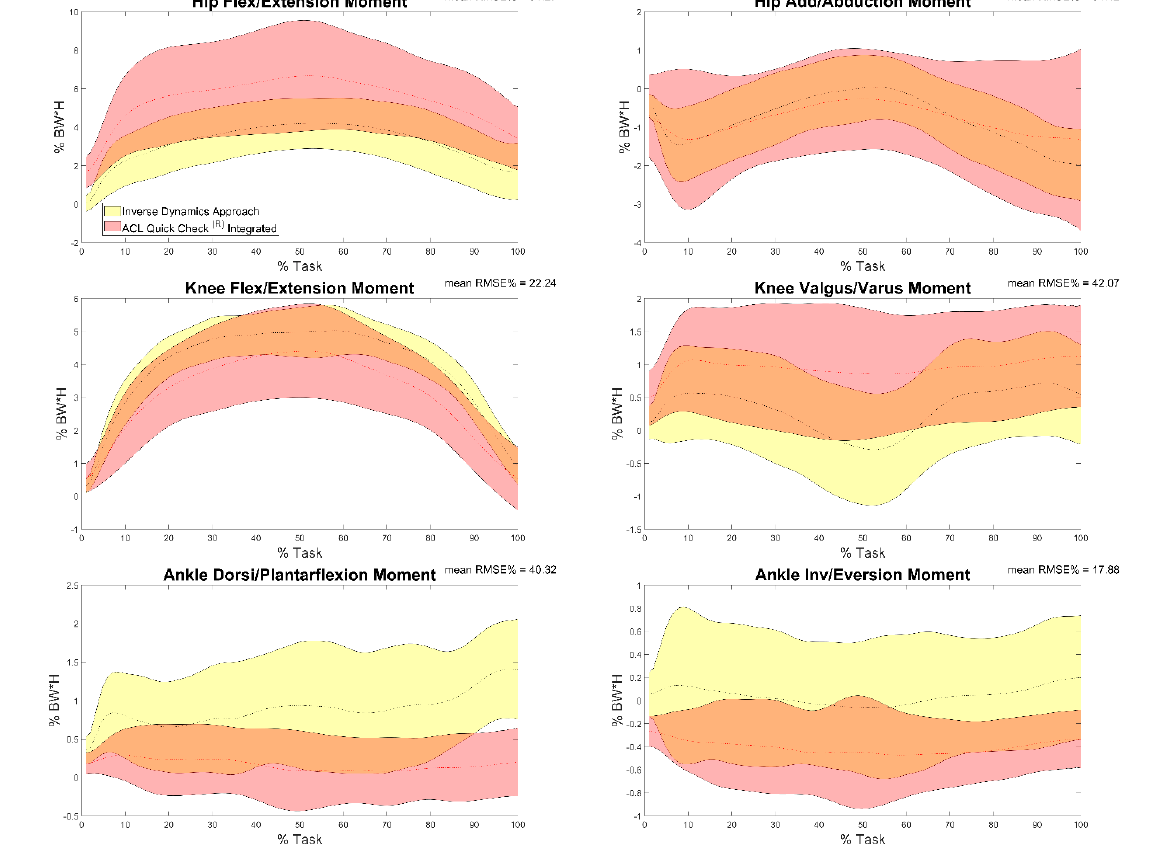
Figure 5. Hip, knee and ankle adduction/abduction and flexion/extension moments during the task calculated through inverse dynamics (yellow) and through ACL Quick Check ® integrated (red) and mean of RMSE% of the comparison between the two. Averages plus and minus one standard deviation are reported as colored bands.